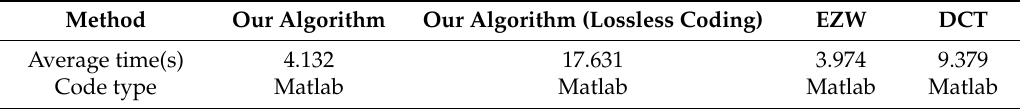
Table 3. Mean time comparison of